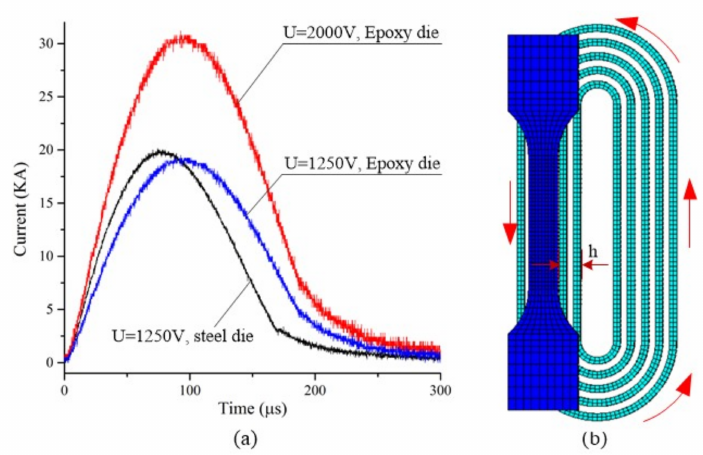
Figure 4. Current through the coil: ( a ) current curves measured by Rogowski coil and ( b ) counterclockwise current loaded on the coil.